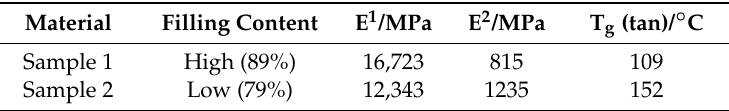
Figure 1. Variation curves of the elasticity modulus, and T g of the non-aged (0 h) samples. ( a ) E'–T curves; ( b ) tan δ –T curves. Table 2. Mechanical parameters of non-aged (0 h) samples. E 1 is the mean modulus of the glassy state, and E 2 is the mean modulus of the rubbery state.